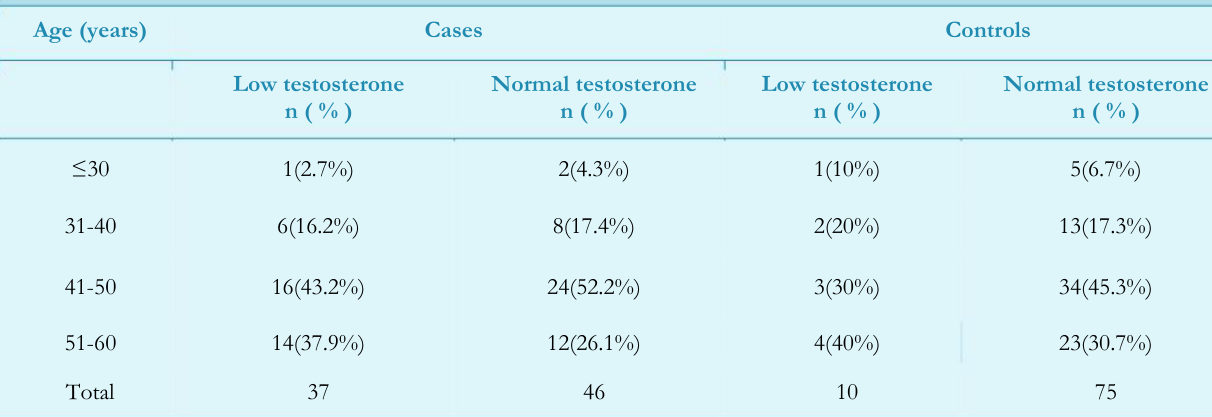
Table 2: Distribution of testosterone deficiency in different age categories Age (years) Cases